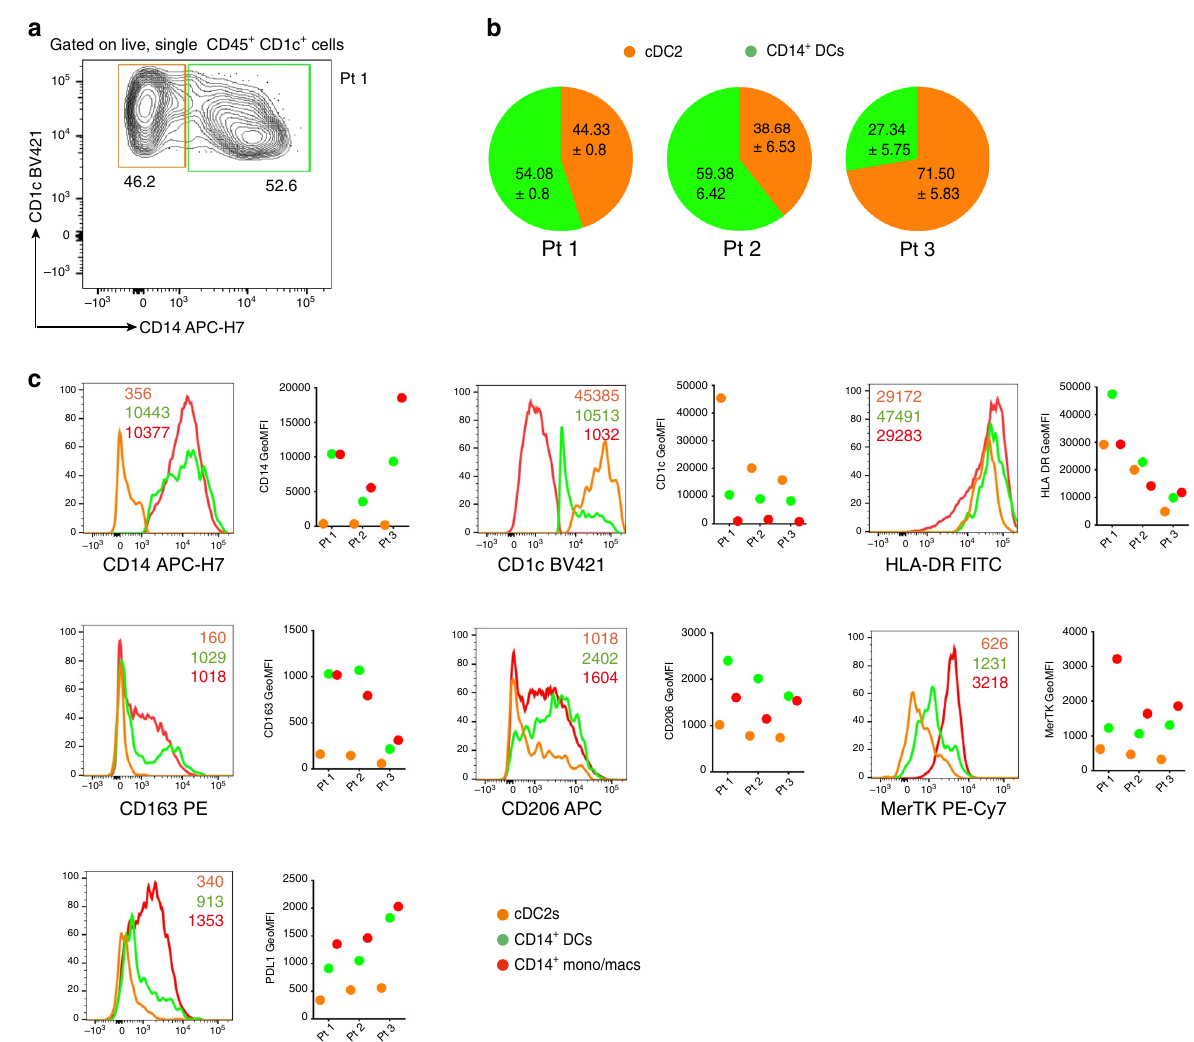
Fig. 7 CD14 + DCs in melanoma lesion phenotypically resemble those recapitulated in human OMC. Human metastatic melanoma lesions were digested and stained ( n = 3). a CD1c + CD14 − (cDC2s) and CD1c + CD14 + (CD14 + DCs) were identi fi ed and gated based on CD1c and CD14 expression in CD45 + CD1c + live single cells. A representative contour plot from one patient (Pt. 1) is shown. b Pie charts report percentages (mean ± SD) of cDC2s and CD14 + DCs across different melanoma patients ( n = 3, in triplicate samples; mean ± SD). c Graphs showing GeoMFI ’ s of the phenotypic analysis of cDC2s, CD14 + DCs and CD14 + mono/macs de fi ned within intra-tumoural CD45 + CD11c + live single cells from melanoma patient samples. Representative histogram plots for each indicated marker are shown. Colour legends indicate: cDC2s (orange), CD14 + DCs (green), CD14 + mono/macs (red). Source data are provided as a Source data fi